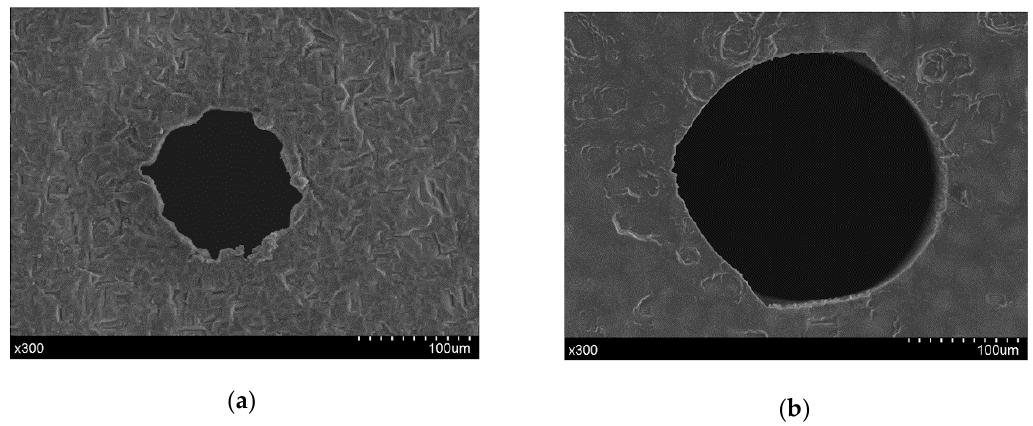
Figure 6. Exit comparison of the micro-trepanning results, in which ( a ) corresponds to direct laser machining, while ( b ) represents chemical-assisted trepanning. The processing parameters are the same as those in Figure 4.